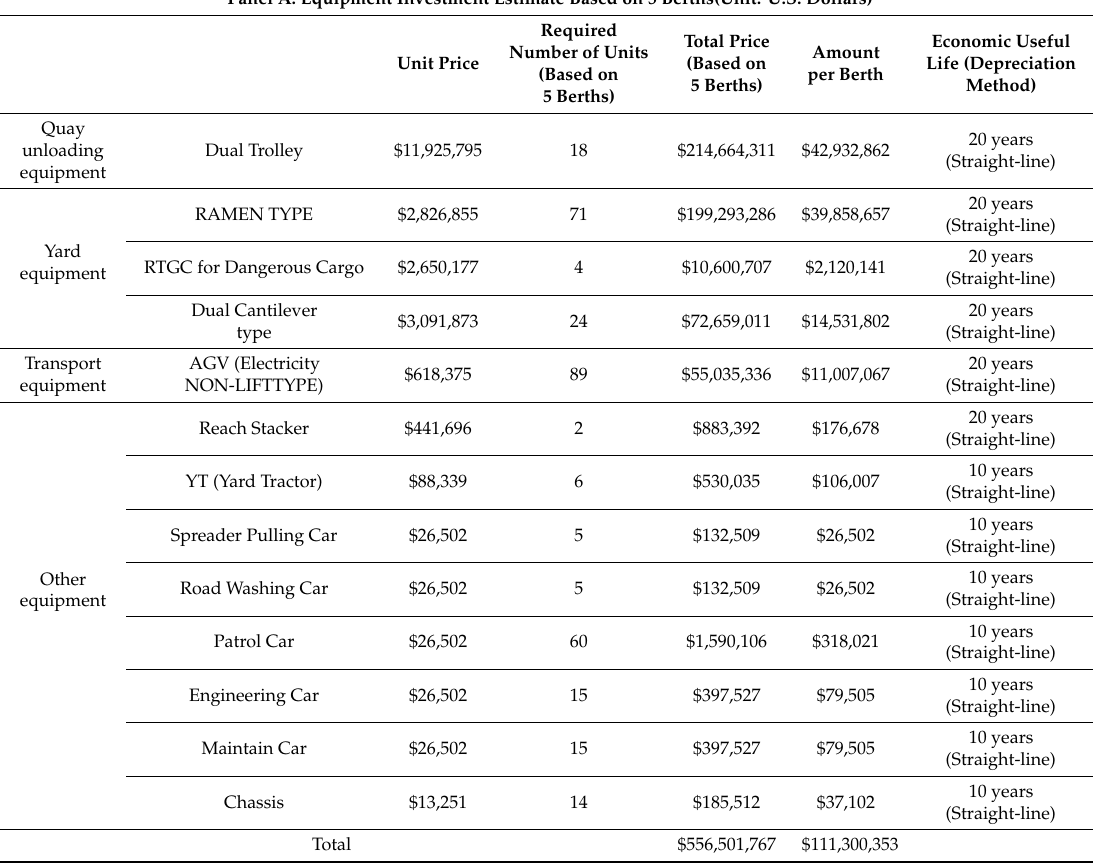
Table 3. Estimation of equipment investment